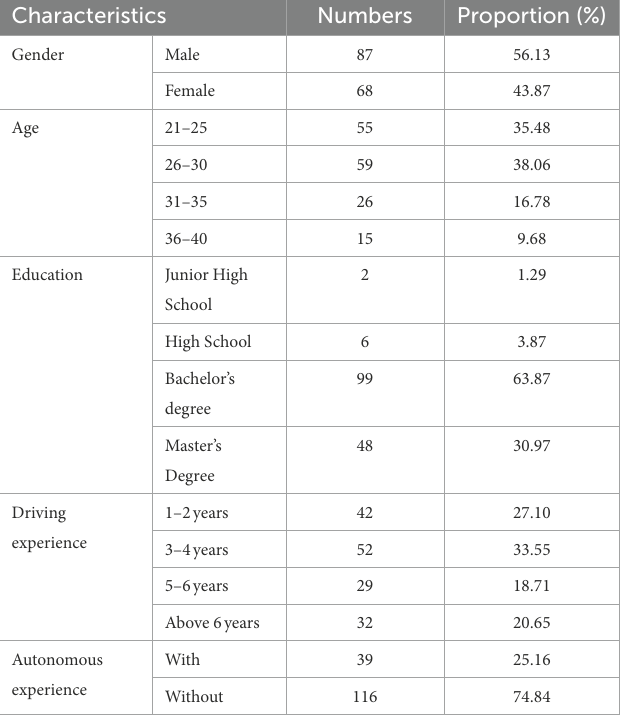
TABLE 1 Basic information about the participants of this study.